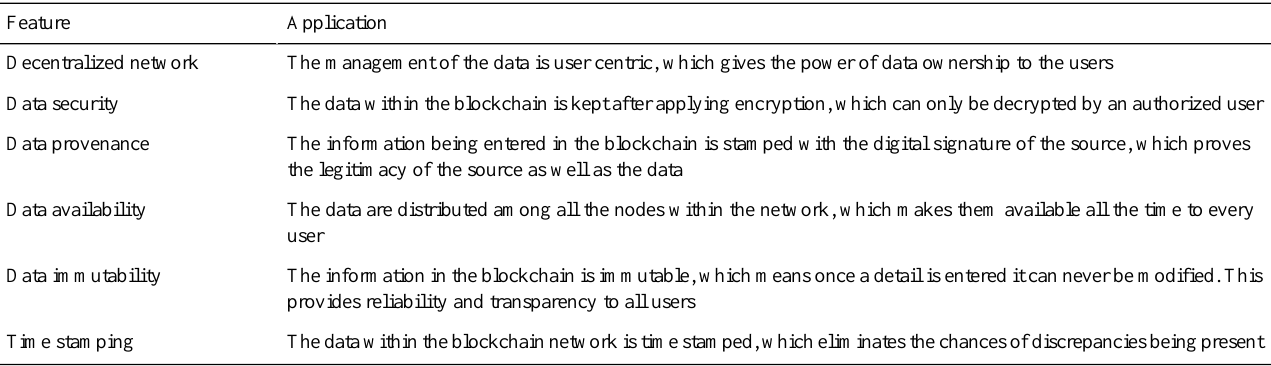
Table 2. Features of blockchain technology and the corresponding application in the digital contact tracing process.